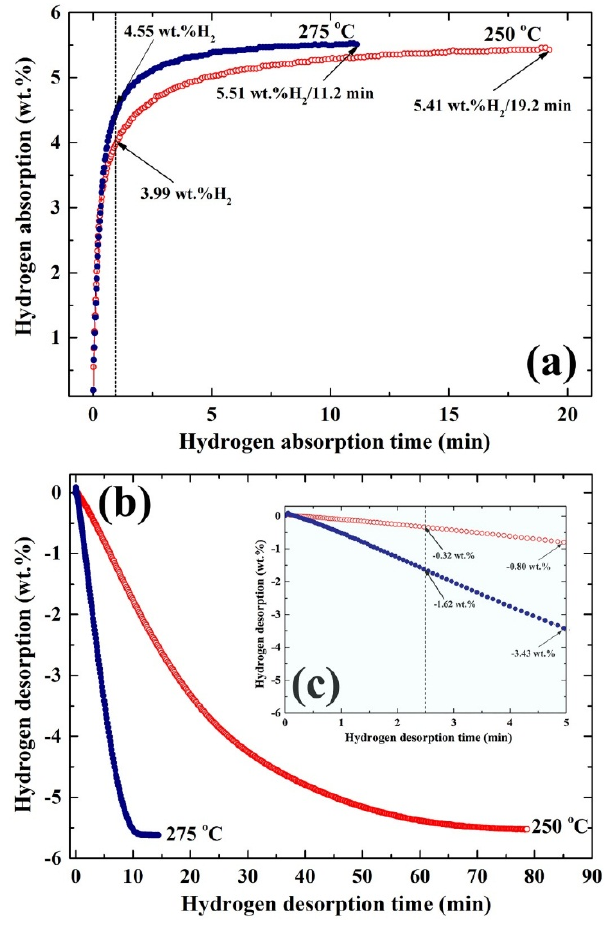
Figure 9. Effect of temperature and time on the ( a ) hydrogenation; and ( b ) dehydrogenation kinetics of nanocomposite MgH 2 /5.2TiC/4.6FeCr powders obtained after ball milling for 50 h. The dehydrogenation kinetics measured at 250 °C (open symbols) and 275 °C (closed symbols) after 5 min of desorption are presented in Figure 9c.